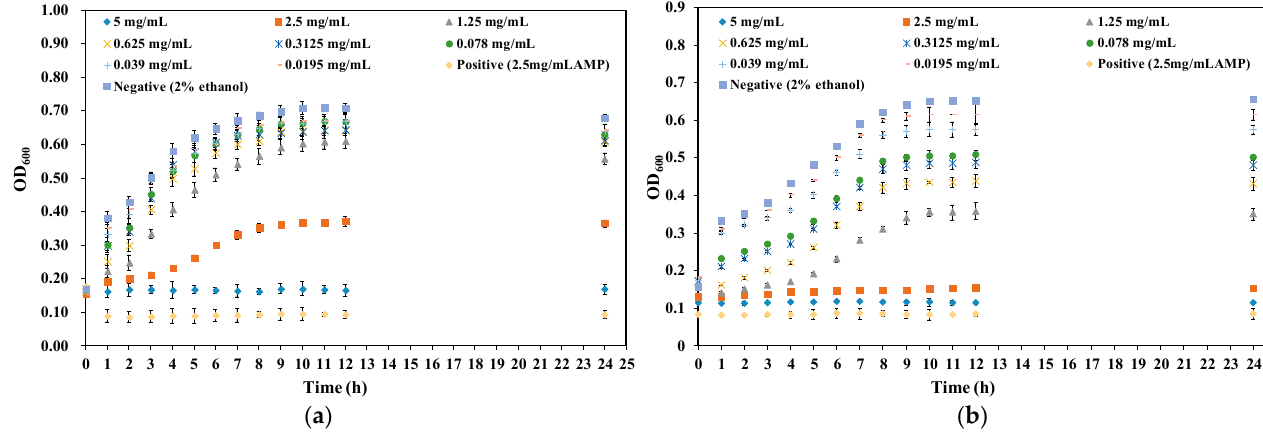
Figure 2. Effect of CA on the growth curve of ( a ) Y. enterocolitica and ( b ) E. sakazakii . 2.3. Effect of CA on Membrane Potential of Y. enterocolitica and E. sakazakii The potential difference between two sides of the cell membrane is referred to as the membrane potential, which is an electrical phenomenon accompanied by cell life activities [18]. Maintaining normal membrane potential is vital for ATP synthesis, as well as the normal physiological function of cells. DiBAC4(3) is a lipophilic anionic fluorescent dye, and it is sensitive to cell membrane potential [19], which is commonly used as an indicator dye for cell membrane potential. The cell is stimulated by the external environment,